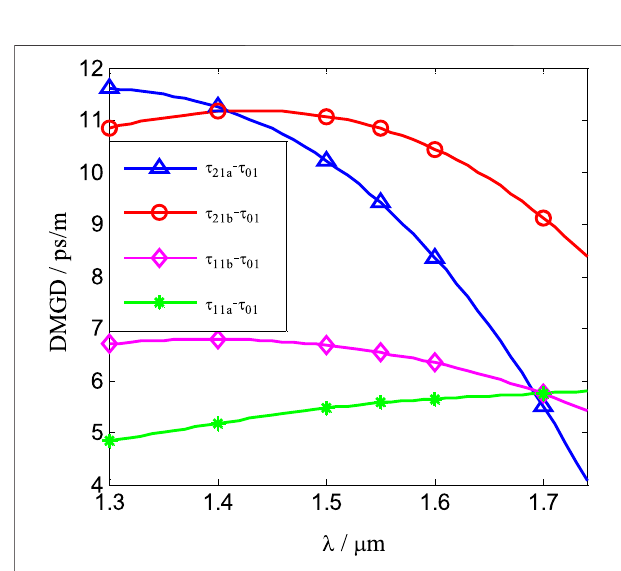
FIGURE 7 | Variations of the DMGDs with input wavelength. The solid lines with stars, diamonds, circles, and triangles represent the DMGDs of the modes LP11a, LP11b, LP21b, and LP21a,